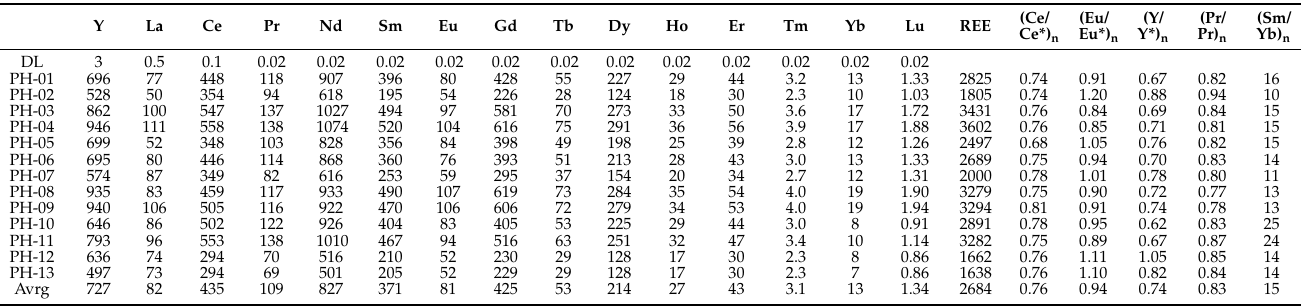
Table 5. Rare-earth element concentrations (ppm) of phosphate